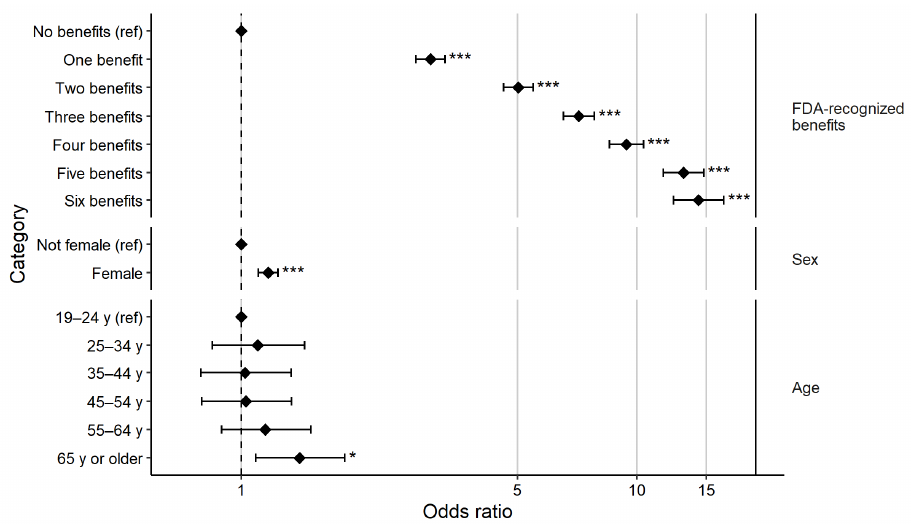
Figure 3. Multivariate binary logistic regression of consideration of dietary fiber when making food choices (versus not considering fiber); error bars show 95% confidence interval; * p < 0.05, *** p < 0.001.